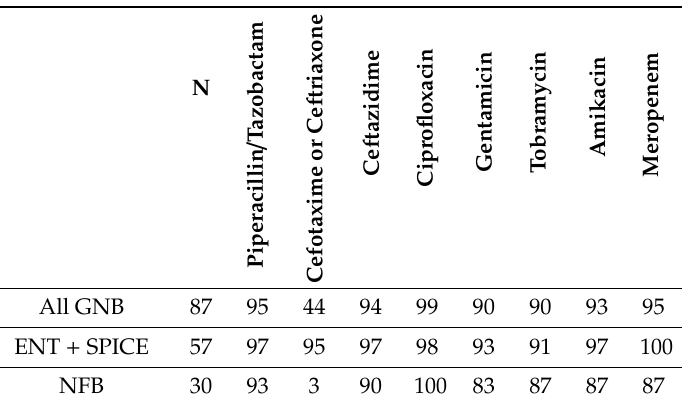
Table 3. Inpatient and Outpatient Susceptibility Patterns